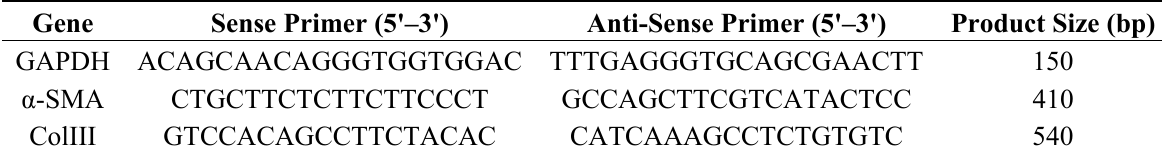
Table 2. Primers sequences for